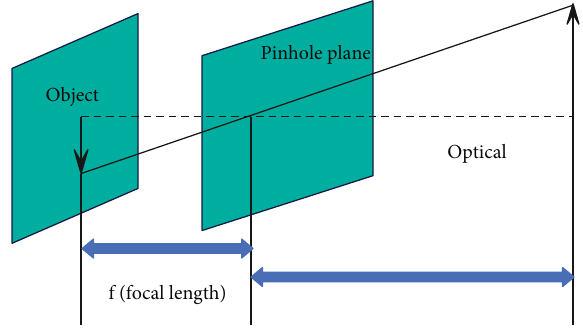
Figure 1: Projector pinhole